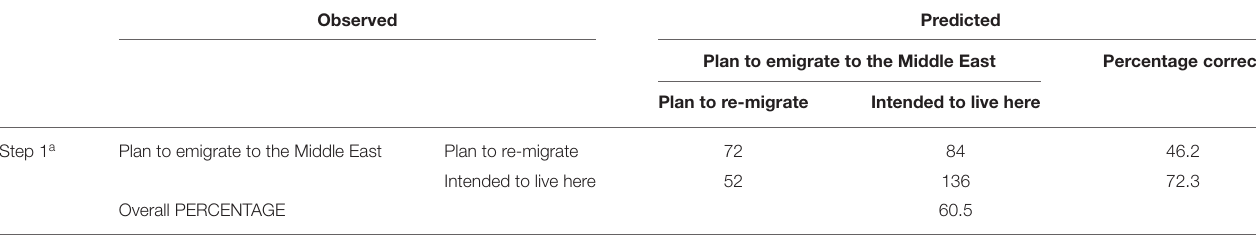
TABLE 13 | Classification table for